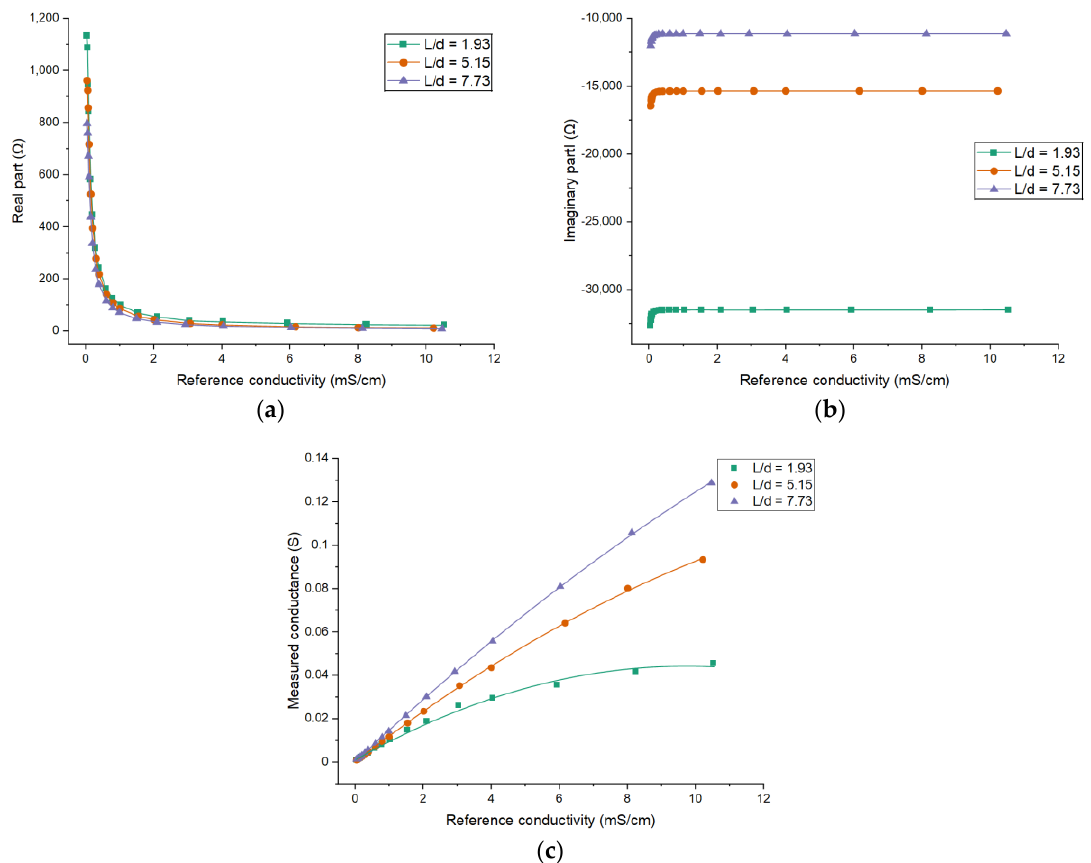
Figure 13. Experimental results for different electrode lengths: The dependence of ( a ) the real part of the impedance; ( b ) the imaginary part of the impedance; ( c ) the measured conductance on the conductivity of the solution when θ = 120 °.